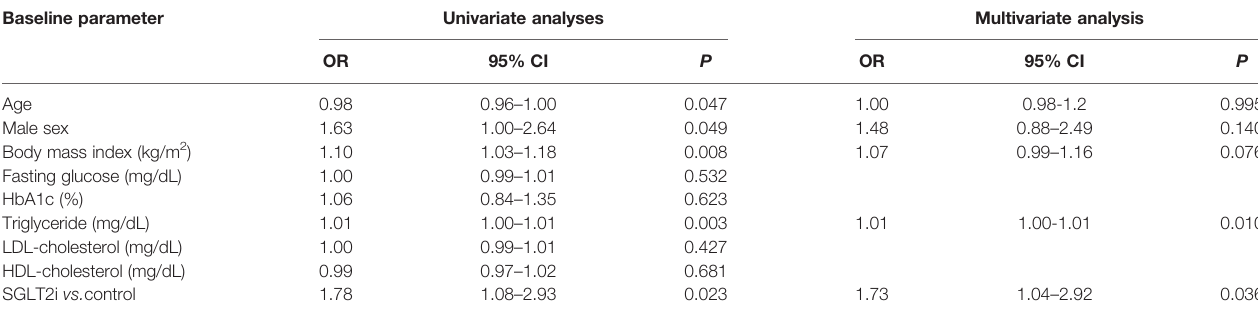
TABLE 4 | Logistic regression analyses for predictors of ALT decrease greater than 15% of baseline over 9 months in the propensity score-matched cohort ( n= 283).